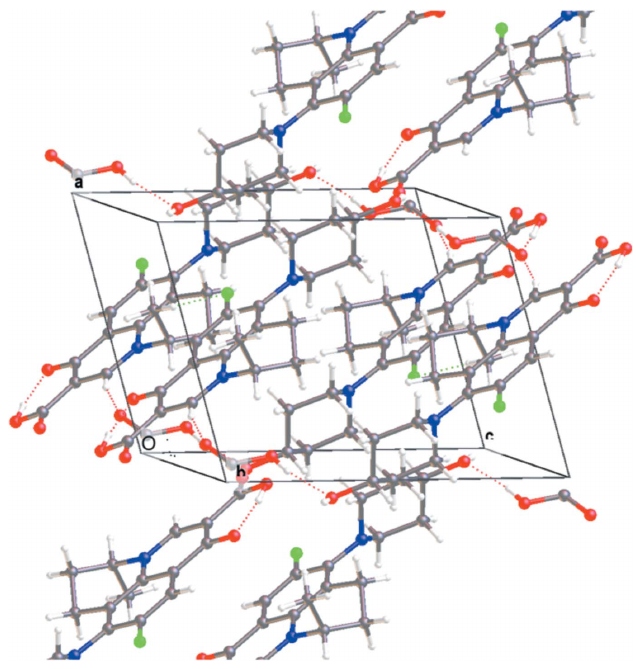
Figure 4 The ring motif between oxalic acid and nadifloxacin in the